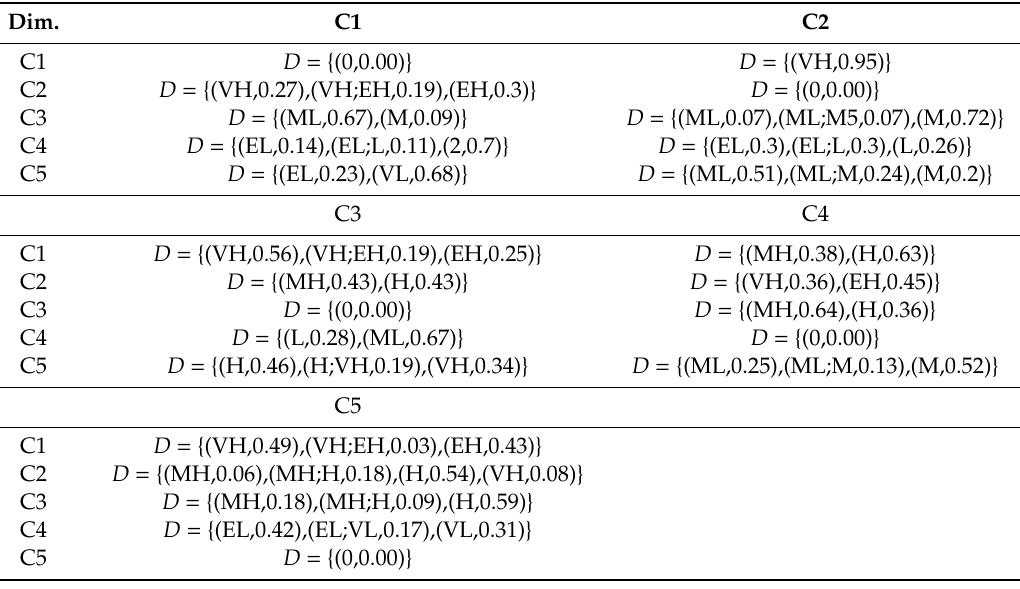
Table 4. Intersection table to combine D 1